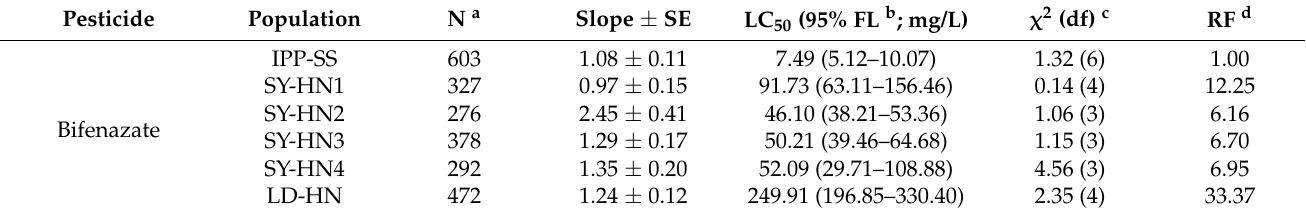
Table 3. Resistance of T. urticae populations from Hainan to recently developed